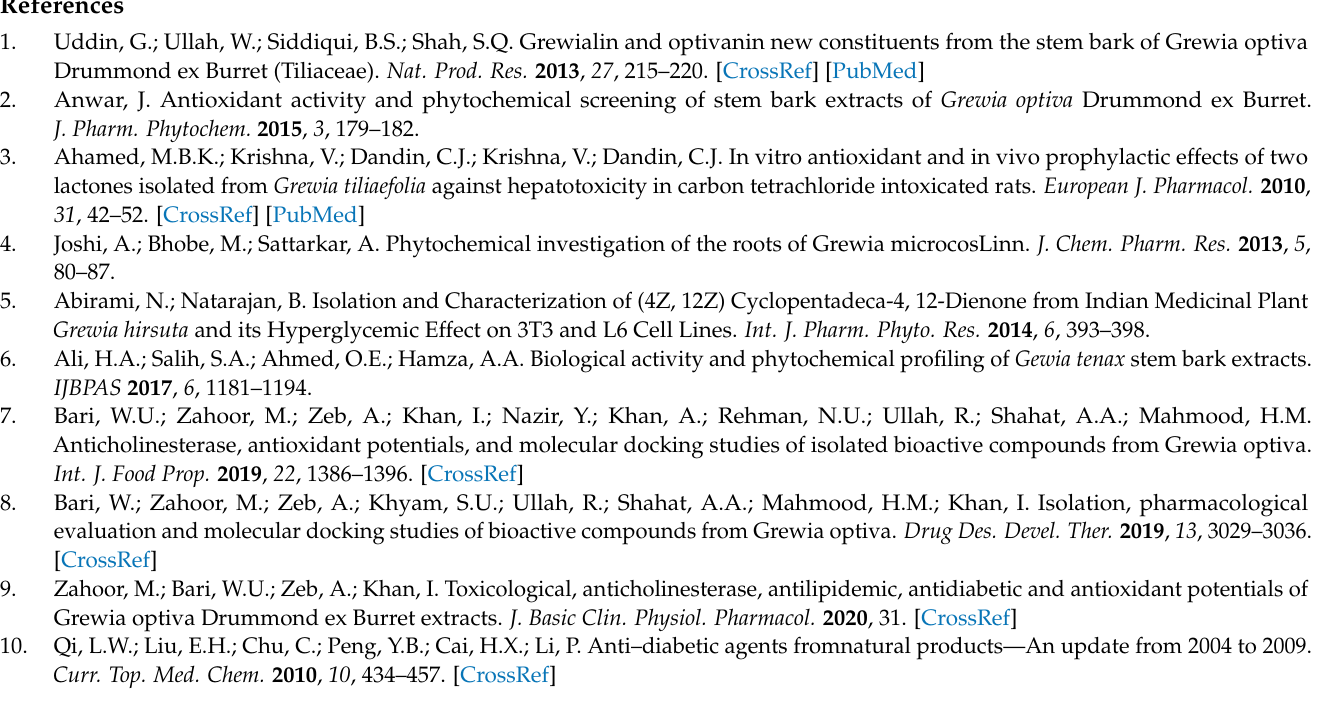
IX , Figure S2: Carbon-13 NMR of compound IX , Figure S3: LC-MS chromatogram of compound IX , Figure S4: Proton NMR of compound X , Figure S5: Carbon-13 NMR of compound X , Figure S6: Proton NMR of compound XI , Figure S7: Carbon-13 NMR of compound XI , Figure S8: HMBC of compound XI , Figure S9: Mass spectra of compound XI , Figure S10: Proton NMR of compound XII , Figure S11: Carbon-13 NMR of compound XII , Figure S12: COSY correlation of compound XII , and Figure S13: HMBC correlation of compound XII